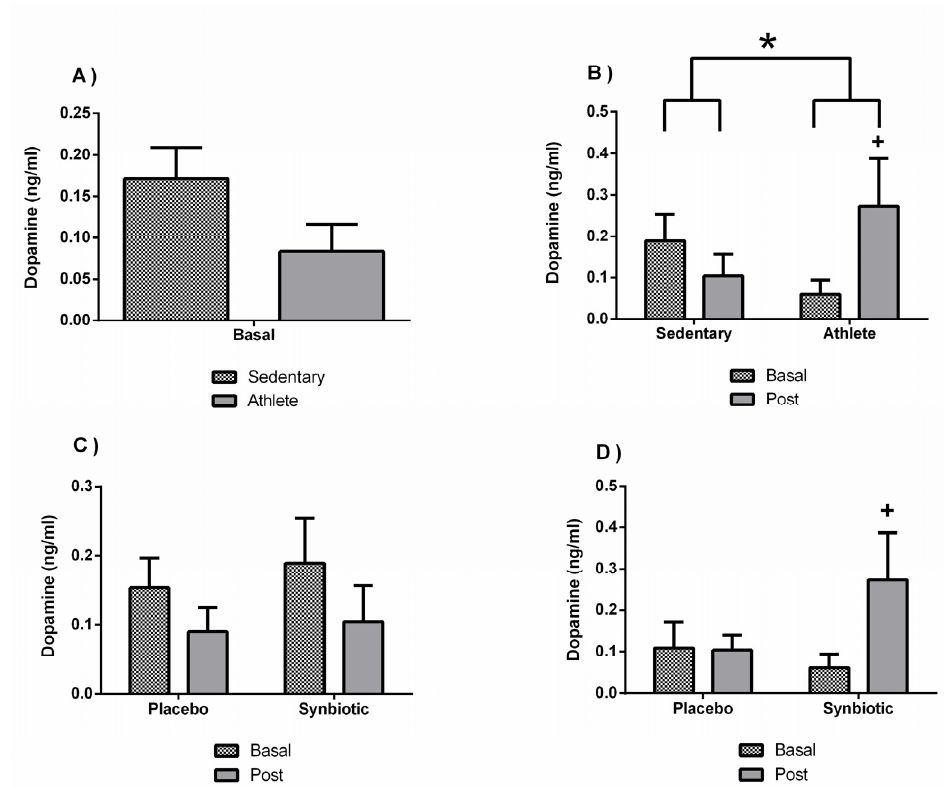
Figure 8. Effect of training and consumption of a synbiotic in this condition on dopamine levels. ( A ) Concentrations of dopamine in sedentary men ( n = 14) and athletes ( n = 13); ( B ) Influence of training on the effects of the synbiotic on the dopamine ( n = 7 and n = 6 in sedentary and athlete groups, respectively); ( C ) Effect of the consumption of the synbiotic on dopamine in sedentary individuals with placebo ( n = 7) or with synbiotic ( n = 7); ( D ) Effect of the consumption of the synbiotic on dopamine in athlete individuals with respect to placebo ( n = 6) or with synbiotic ( n = 7). The determinations are expressed by the mean ± SD of each of the samples. * p < 0.05 sedentary group versus athlete group; + p < 0.05 with respect to the